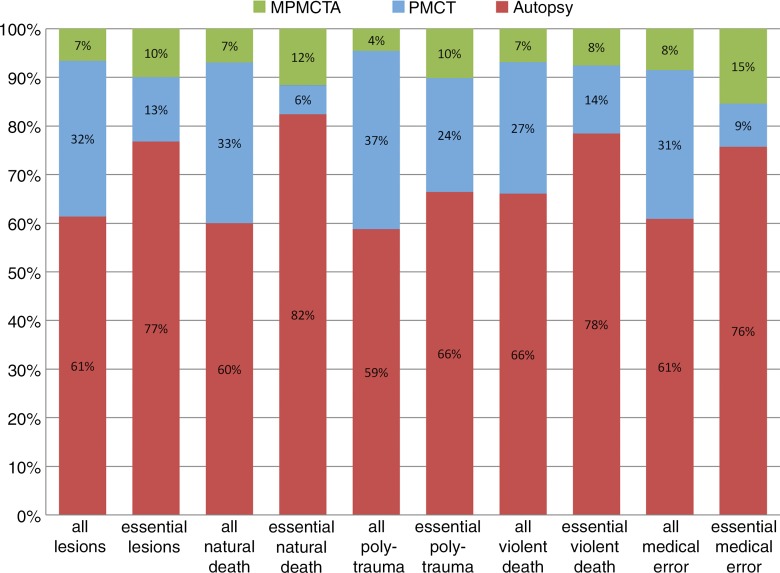
Graph of additional postmortem findings. (a) Additional findings obtained by using imaging with autopsy. Autopsy findings as a percentage of all findings are in red. Additional findings not observed at autopsy but identified at postmortem CT are in blue. Green indicates findings undiscovered at both autopsy and postmortem CT but detected at postmortem CT angiography. There is a relatively high effect of postmortem CT in polytrauma evaluation and of postmortem CT angiography in medical errors and natural death. (b) Additional findings obtained by using angiography with postmortem CT, and then by performing an autopsy. Postmortem CT findings as a percentage of all findings are in blue. Additional findings detected by using postmortem CT angiography are in green. Finally, findings only detected at autopsy are in red. Notice the relatively high effect of autopsy in medical errors and natural death, and the low effect in evaluation of polytrauma.